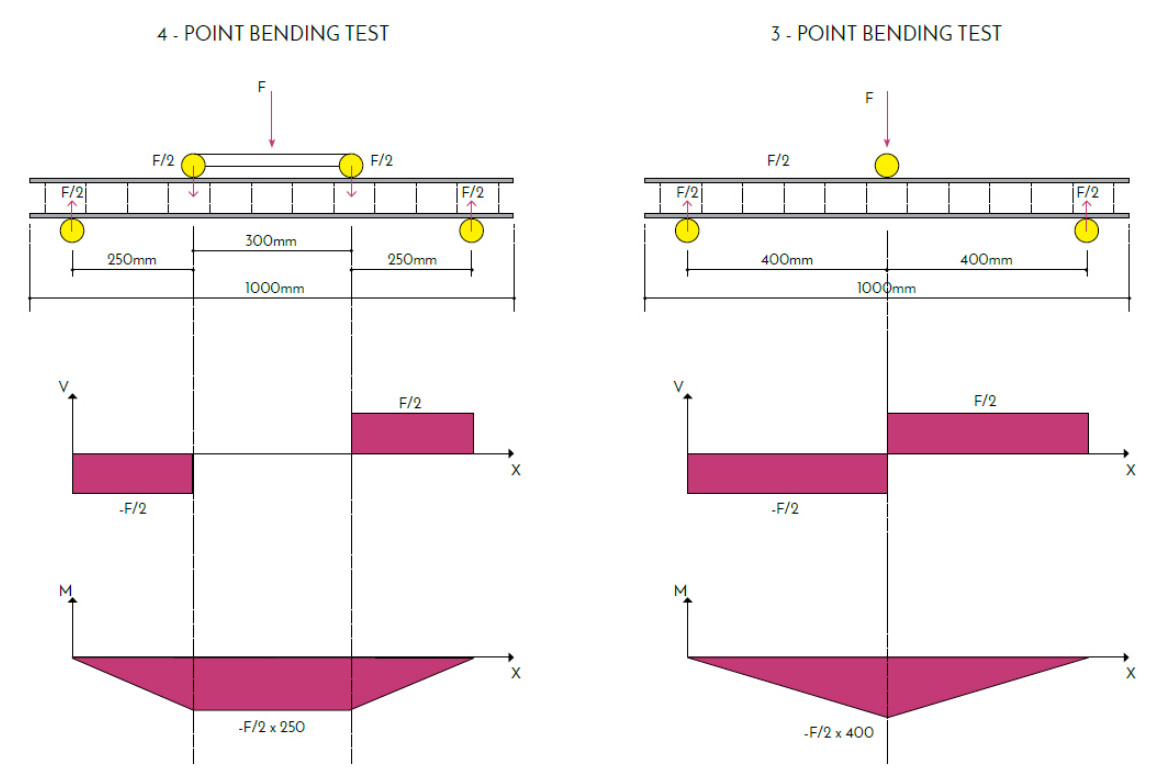
Fig. 6: Comparison between a 4-point bending test and a 3-point bending